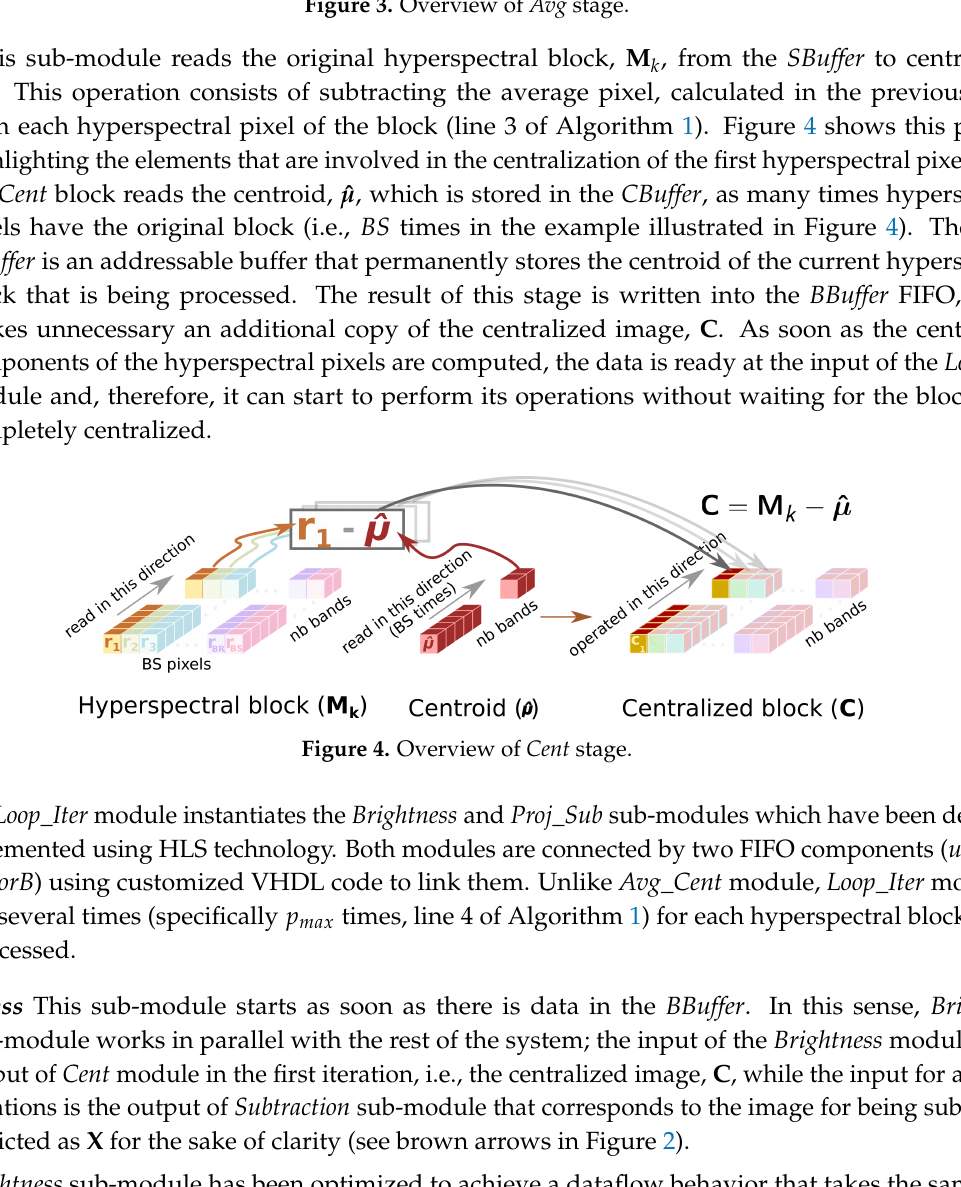
Figure 3. Overview of Avg stage.